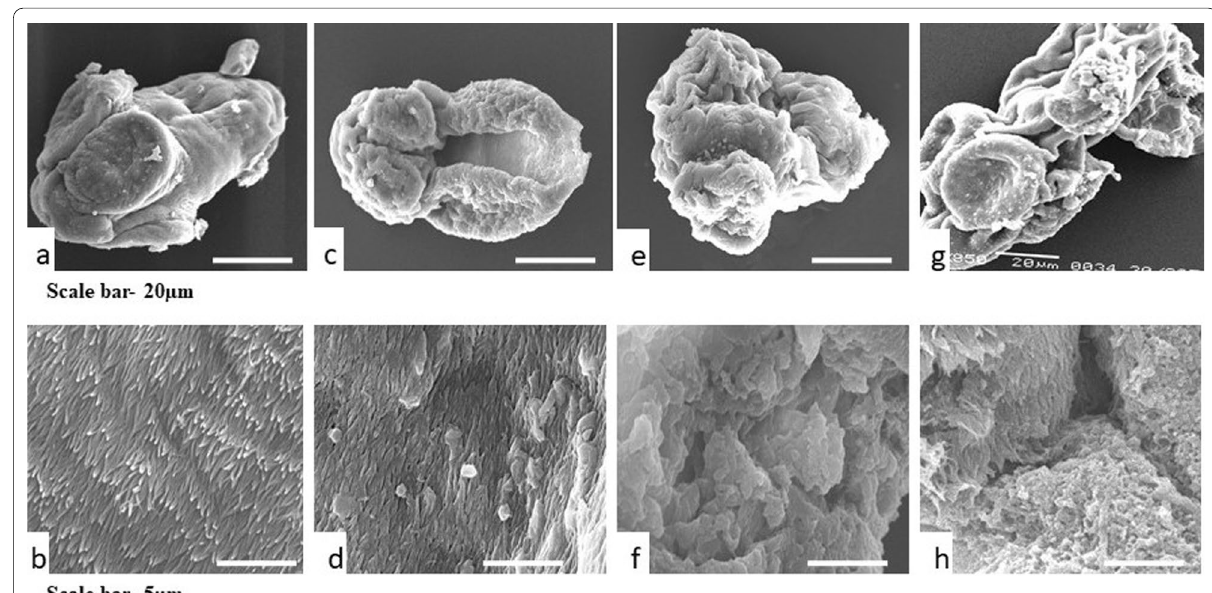
Fig. 2 Scanning electron micrographs of newly excysted juveniles of H. diminuta . a , b Control juvenile, showing intact body contour, suckers and microtriches; c , d Juveniles exposed to PZQ (1 mg/ml), showing distorted body architecture, suckers and clumped microtriches; e , f Juveniles exposed to C. bonducella extract (30 mg/ml), showing altered body structure, closed suckers and corroded microtriches; g , h Juveniles exposed to C. joufra extract (30 mg/ml), showing shrunken altered body structure, damaged sunken suckers, and corroded